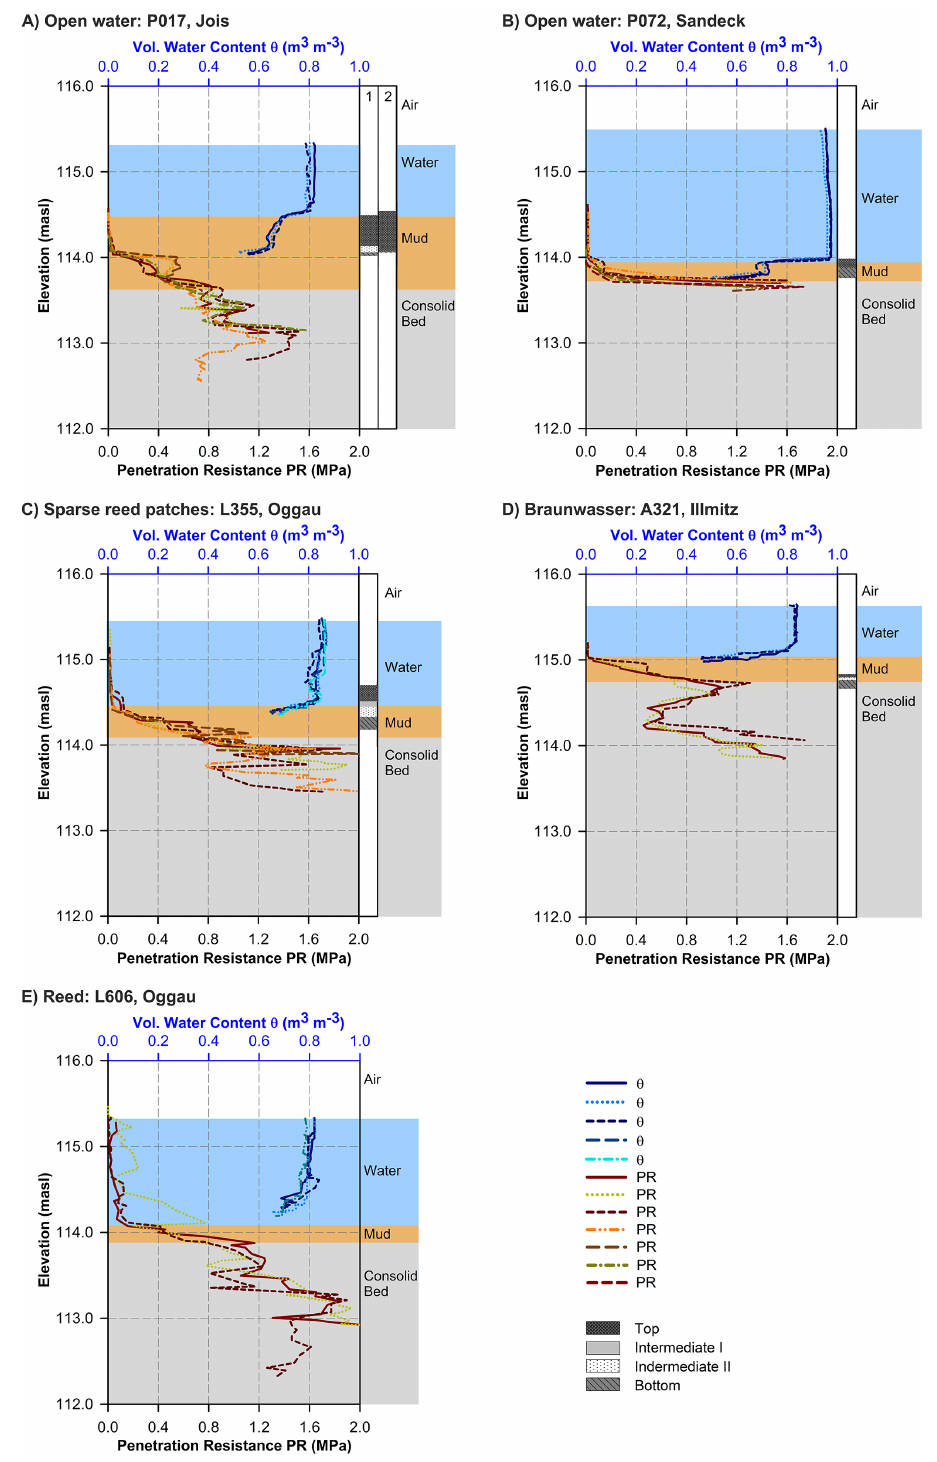
Figure 6. Representative ecotope-specific CSPS profiles for the in situ layer delineation are shown for the open water (a, b) , sparse reed patches (c) , Braunwasser (d) , and reed (e) . The HP measurement of the volumetric water content θ (m 3 m − 3 ) delineates the water–mud interface by its sudden decline. The mud–bed sediment interface is detected by the PR 1st peak (MPa) at the shallowest significant peak accompanied by an abrupt change of slope. In the reed a lutocline is absent, but the mud layer composed of less consolidated sediments and rhizomes is delineated from PR 0 . 2 to PR 1st peak